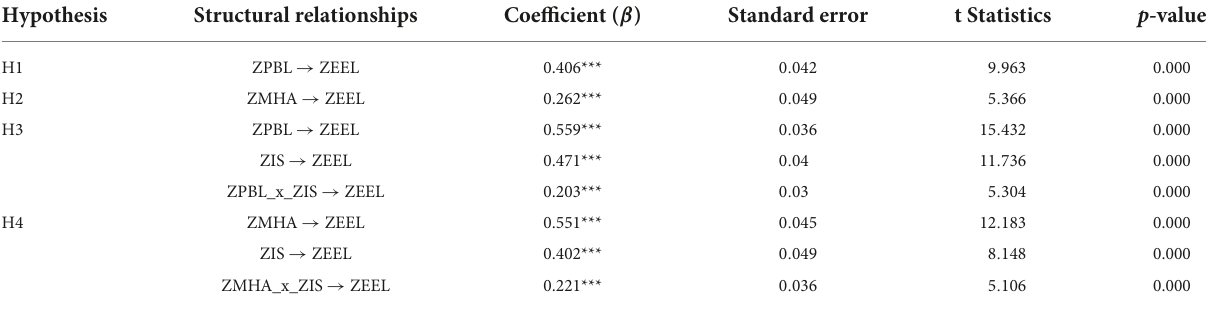
TABLE 5 Direct path effect